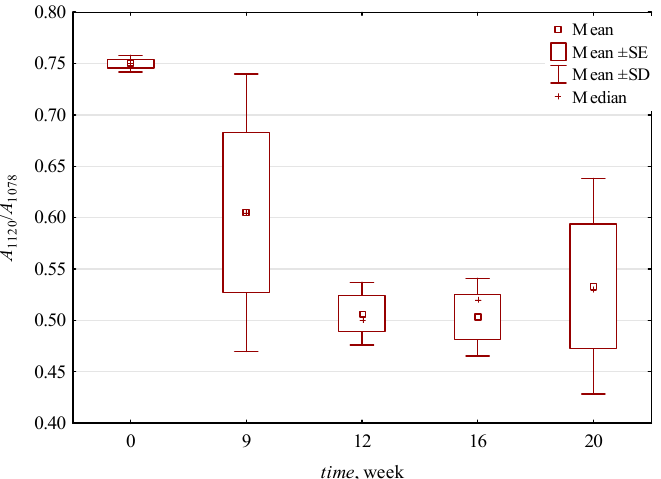
Figure 11. Values of crystallinity R = A 1120 / A 1078 based on deconvolution.